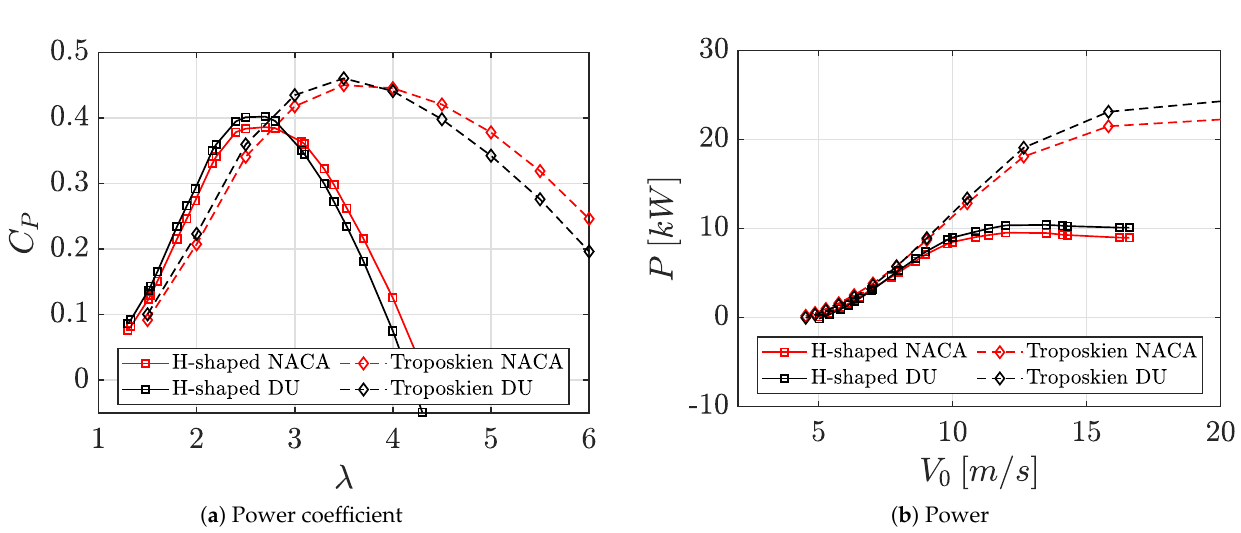
Figure 13. Sensitivity analysis to airfoil shapes: NACA0021 and DU06W200 of small H-shaped and Troposkein Savona